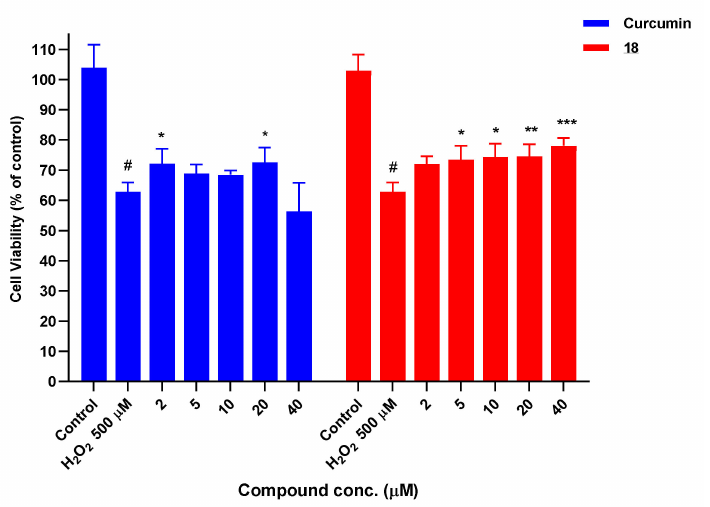
Figure 26. SH-SY5Y cells were differentiated by RA treatment (10 µ M) and 1% FBS DMEM: F12 medium on days 2, 4, and 6 before antioxidant treatment on day 8. Cells were treated with curcumin or 18 for 24 h at 0, 2, 5, 10, 20, and 40 µ M. Afterward, cells were exposed to H 2 O 2 500 µ M for 24 h. Cell viability was measured by the MTT assay. Data are presented as the Mean ± SEM of four independent experiments carried out in triplicate. # p < 0.001 vs. vehicle-treated control. * p < 0.05, ** p < 0.01, *** p < 0.001 vs. cells treated only with H 2 O 2